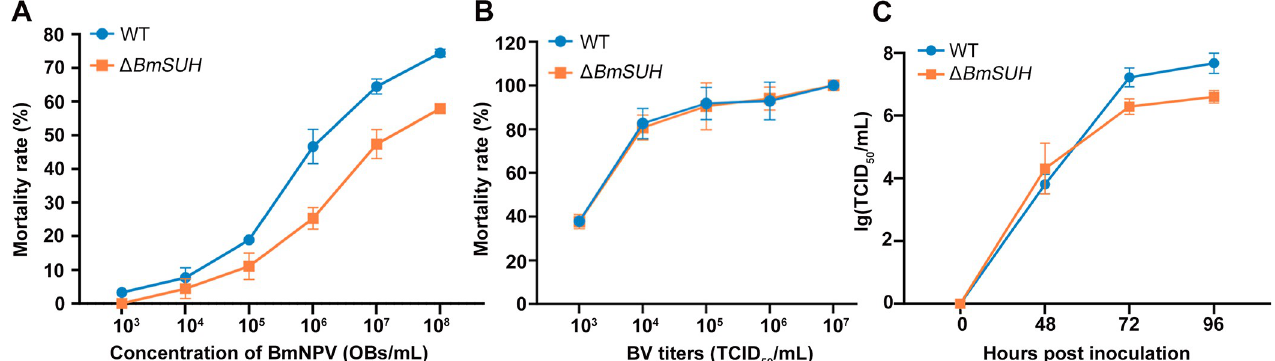
Fig 3. Larval bioassays. (A) The mortality analysis of fourth-instar WT and Δ BmSUH after being orally infected with the BmNPV at concentration of 1 × 10 3 , 1 × 10 4 , 1 × 10 5 , 1 × 10 6 , 1 × 10 7 and 1 × 10 8 OB/mL (n = 30). (B) The mortality of fifth-instar WT and Δ BmSUH after BV injection (n = 30). (C) The production of infectious BVs in the hemolymph of fourth-instar WT and Δ BmSUH after orally infected with 1 × 10 8 OB/mL BmNPV. The hemolymph was taken at designed time points and the BV titers were determined by TCID 50 endpoint dilution assays. Each data point was determined from the average of at least three independent experiments. The data represents the mean ± SEM.